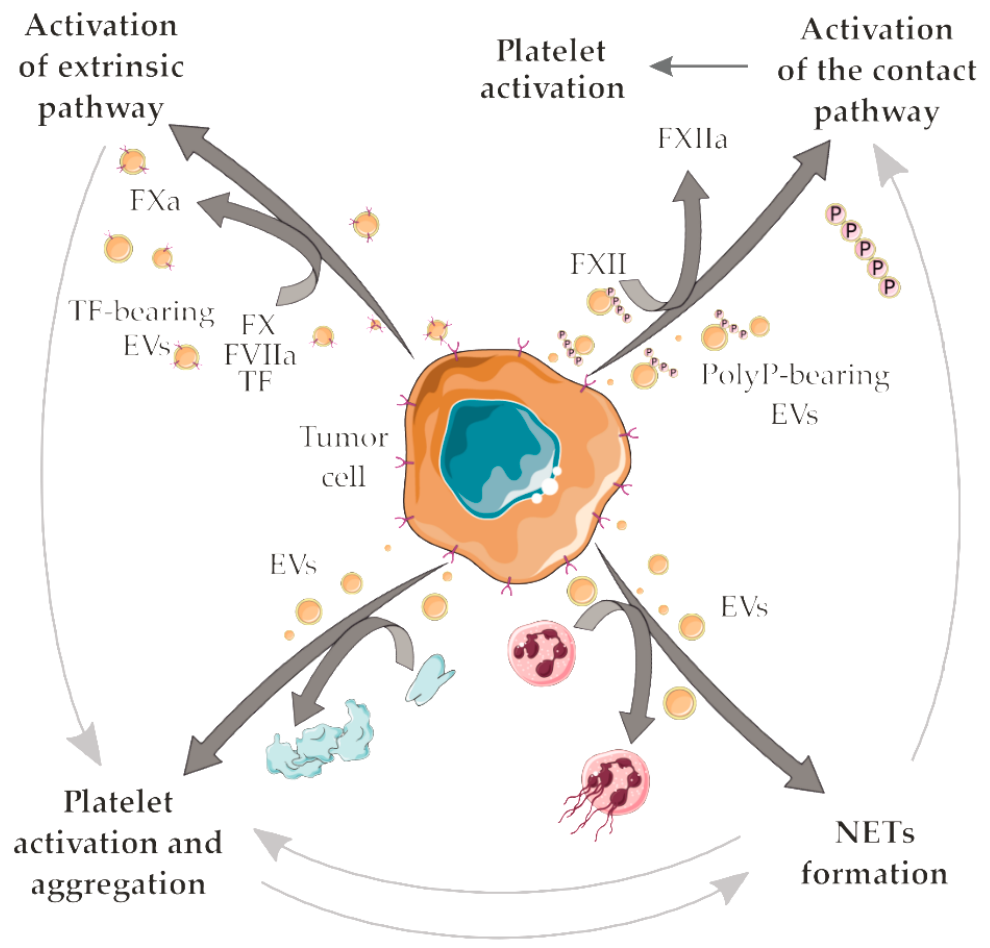
Figure 3. Possible crosstalk between the proposed mechanisms for tumor-derived EVs in cancer-associated thrombosis. Tumor-derived TF + EVs initiate the extrinsic pathway of coagulation. TF is a high-affinity receptor for coagulation factor VII/VIIa (FVII/FVIIa), culminating in the activation of the factors X (FX) into factor Xa (FXa). In turn, FXa mediates the proteolytic conversion of prothrombin to thrombin, a serine protease that amplifies the coagulation cascade and generates fibrin, which stabilizes the platelet plug in clot formation. Further thrombin generation accounts for an indirect mechanism for platelet activation/aggregation. EVs may elicit direct platelet activation/aggregation. Tumor-derived polyP+ EVs initiate the contact pathway of coagulation, mediating the activation of factor XII (FXII) into factor XIIa (FXIIa) by negatively charged surfaces such as those provided by polyP. Further reactions of the contact pathway also culminate with thrombin formation, fibrinogen cleavage into fibrin and platelet activation. Interaction of neutrophils with tumor-derived EVs may support NETs release thus eliciting several NETs-dependent prothrombotic mechanisms. NETs provide additional surfaces that support the contact pathway activation. In addition, crosstalk between platelets and NETs may play an important role in the establishment of cancer-associated thrombosis. Servier Medical Art, https://smart.servier.com/, was used to create this figure, licensed under a Creative Commons Attribution 3.0 Unported License.